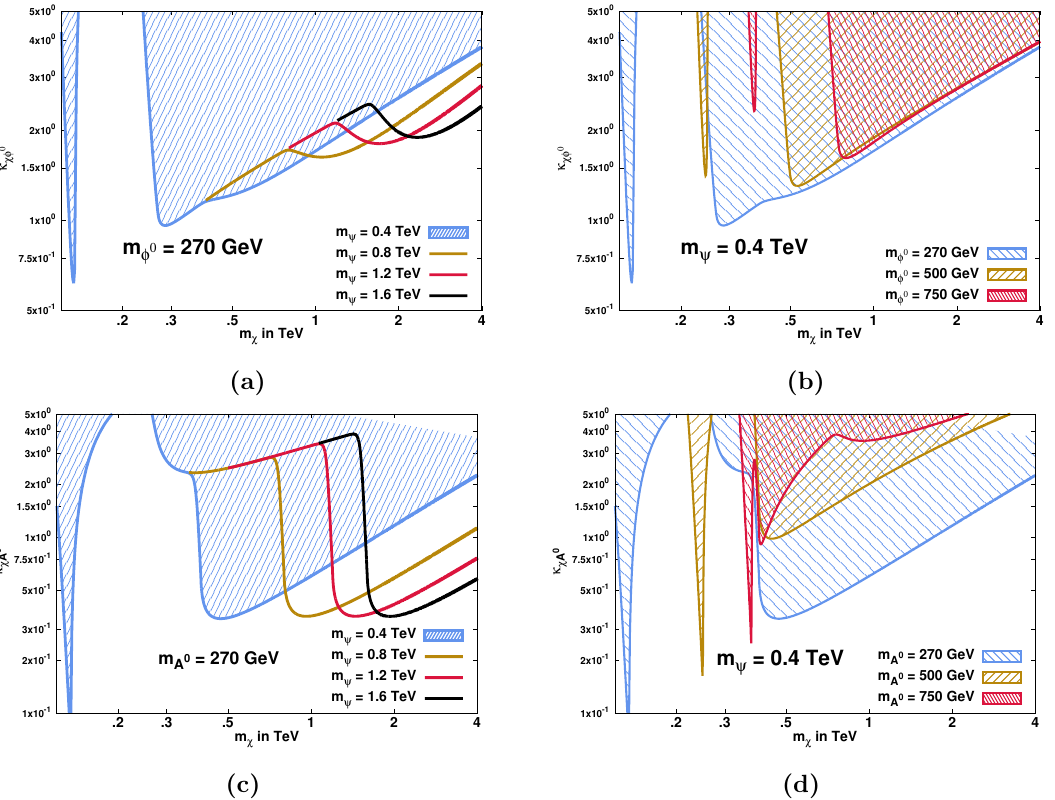
Figure 6. In (cid:12)gure 6a we depict the relic density contours satisfying (cid:10) c h 2 = 0 : 1138 (cid:6) : 0045 in the plane de(cid:12)ned by fermionic DM mass m (cid:31) and scalar DM mediator coupling (cid:20) for a (cid:12)xed scalar (cid:31)(cid:30) 0 mediator mass of 270 GeV corresponding to the four choice of VLQ masses 400, 800, 1200 and 1600 GeV respectively. In (cid:12)gure 6b we have exhibited the constant relic density contours for a (cid:12)xed VLQ mass of 400 GeV corresponding to the three di(cid:11)erent choices of the portal scalar mass 270, 500 and 750 GeV respectively. Similarly, in (cid:12)gures 6c and 6d the constant relic density contours are drawn for the (cid:12)xed pseudo-scalar mass of 270 GeV corresponding to four VLQ masses and for the (cid:12)xed VLQ mass of 400 GeV corresponding to the three pseudo-scalar masses respectively. Shaded regions appearing in blue, golden yellow and red correspond to the relic density allowed regions for the portal mass of 270, 500 and 750 GeV respectively.